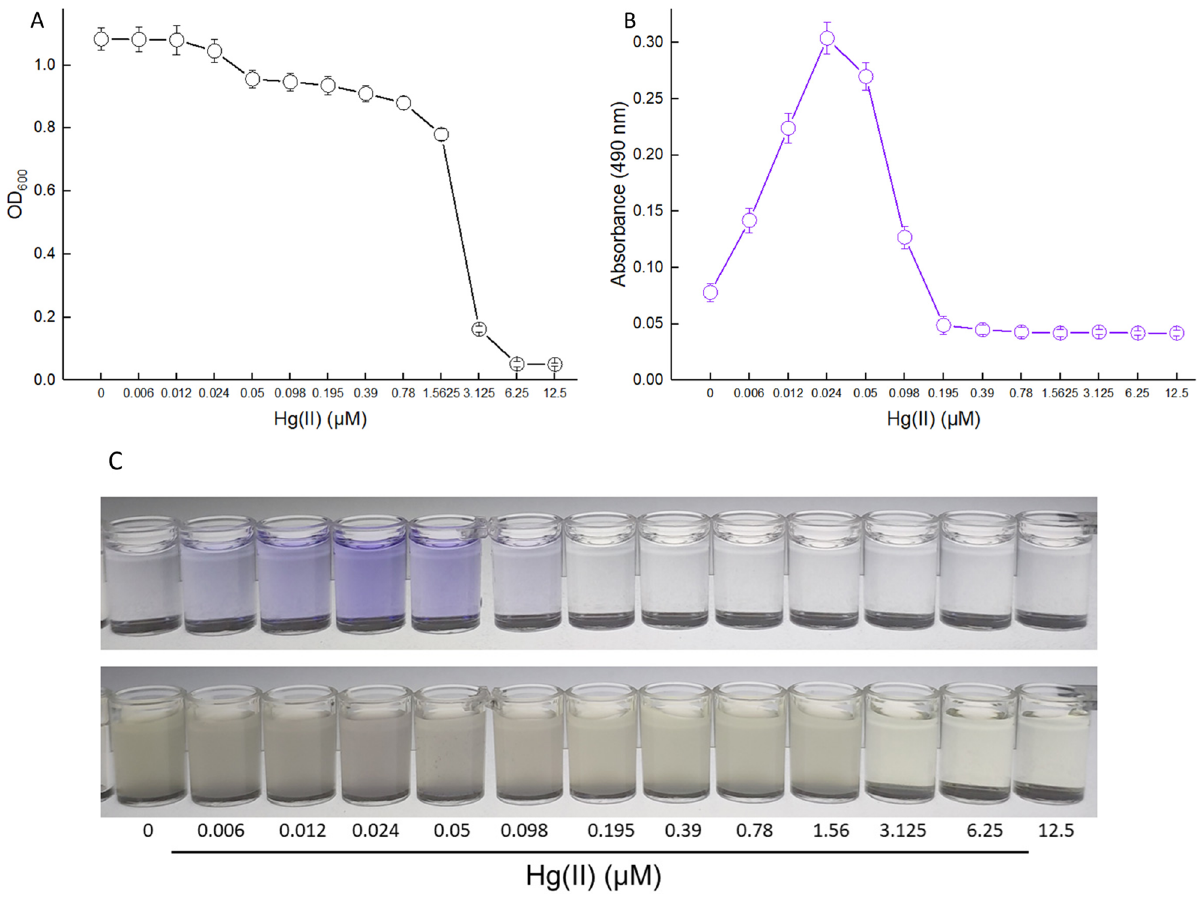
Figure 6. The response of resting TOP10/pPmer-vio induced with increased concentrations of Hg(II). E. coli TOP10 harboring the plasmid pPmer-vio was inoculated in LB broth containing increased concentrations of Hg(II) at 37 °C for 12 h. The bacterial density (OD 600 ) was determined ( A ), and then the violacein was extracted and quantified at 490 nm ( B ). The induced culture and the butanol phase with increased concentrations of Hg(II) exposure ( C ). Shown is one representative of three independent experiments with similar